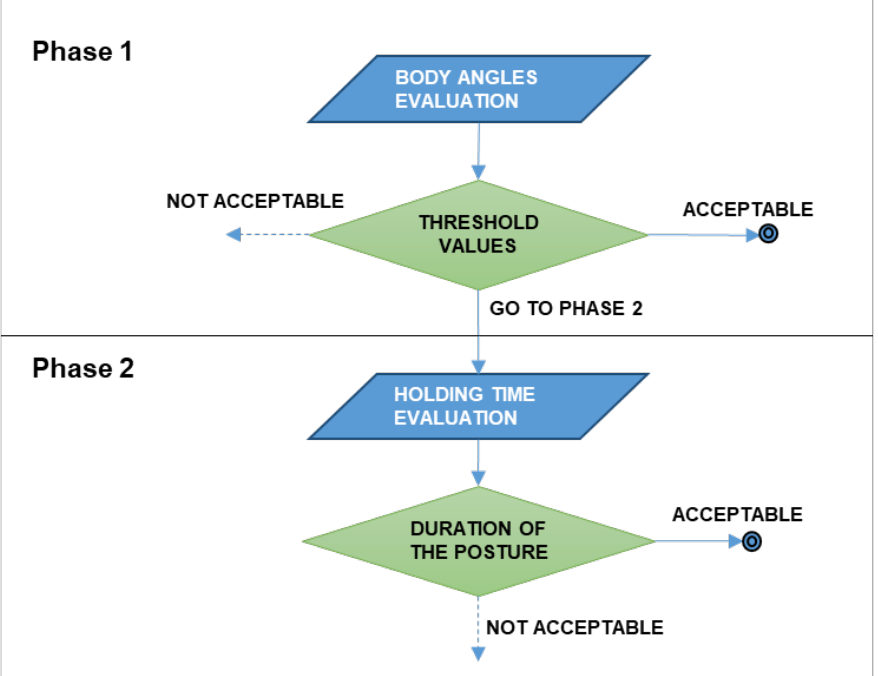
Figure 2. Scheme of the assessment procedure provided by the ISO 11226 standard.